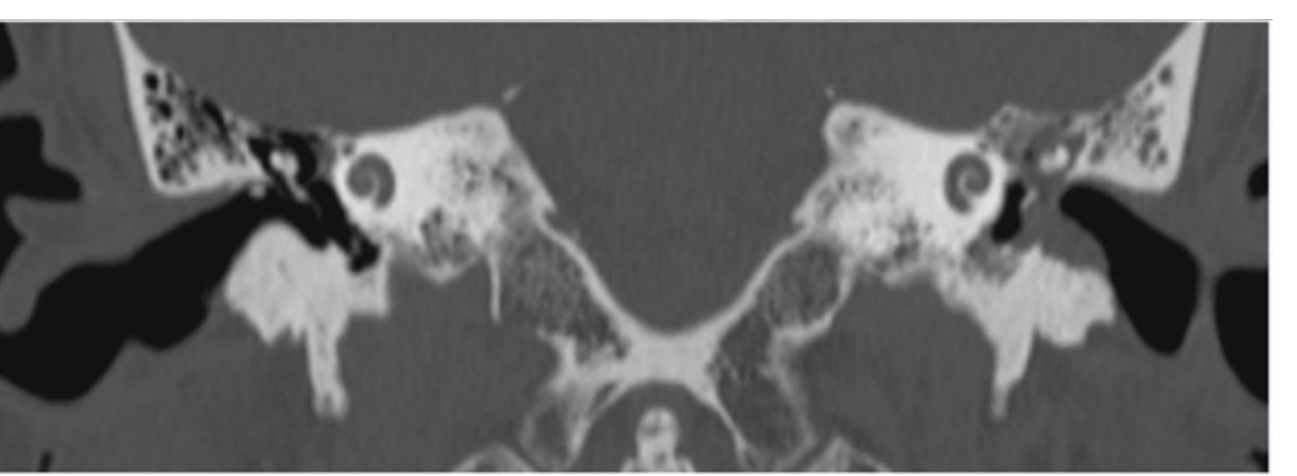
Figure 2. Patient 1, CT scan: evidence of soft tissue density located in the hypotympanic region of the middle ear cavity and in the floor of the left EAC with related bone erosion of the anteroinferior wall of the EAC.